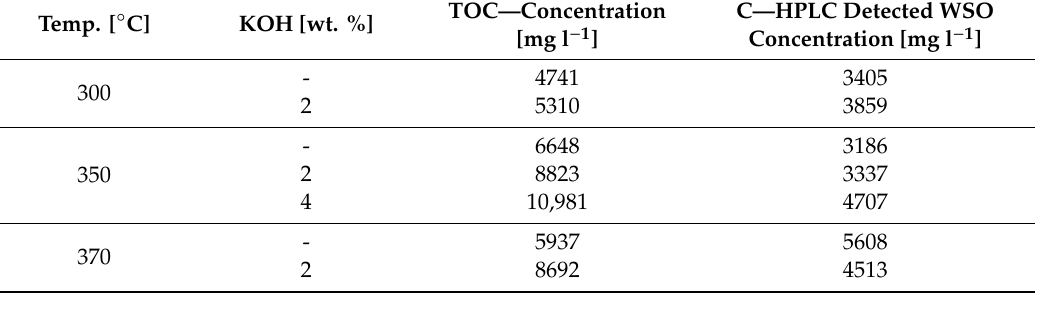
Table 4. Total organic carbon (TOC) concentration of WSO, influence of KOH at 300–350–370 ◦ C. Compared to carbon concentration calculated by HPLC detected compounds. Test performed at 5 min and 10 wt. % B / W.